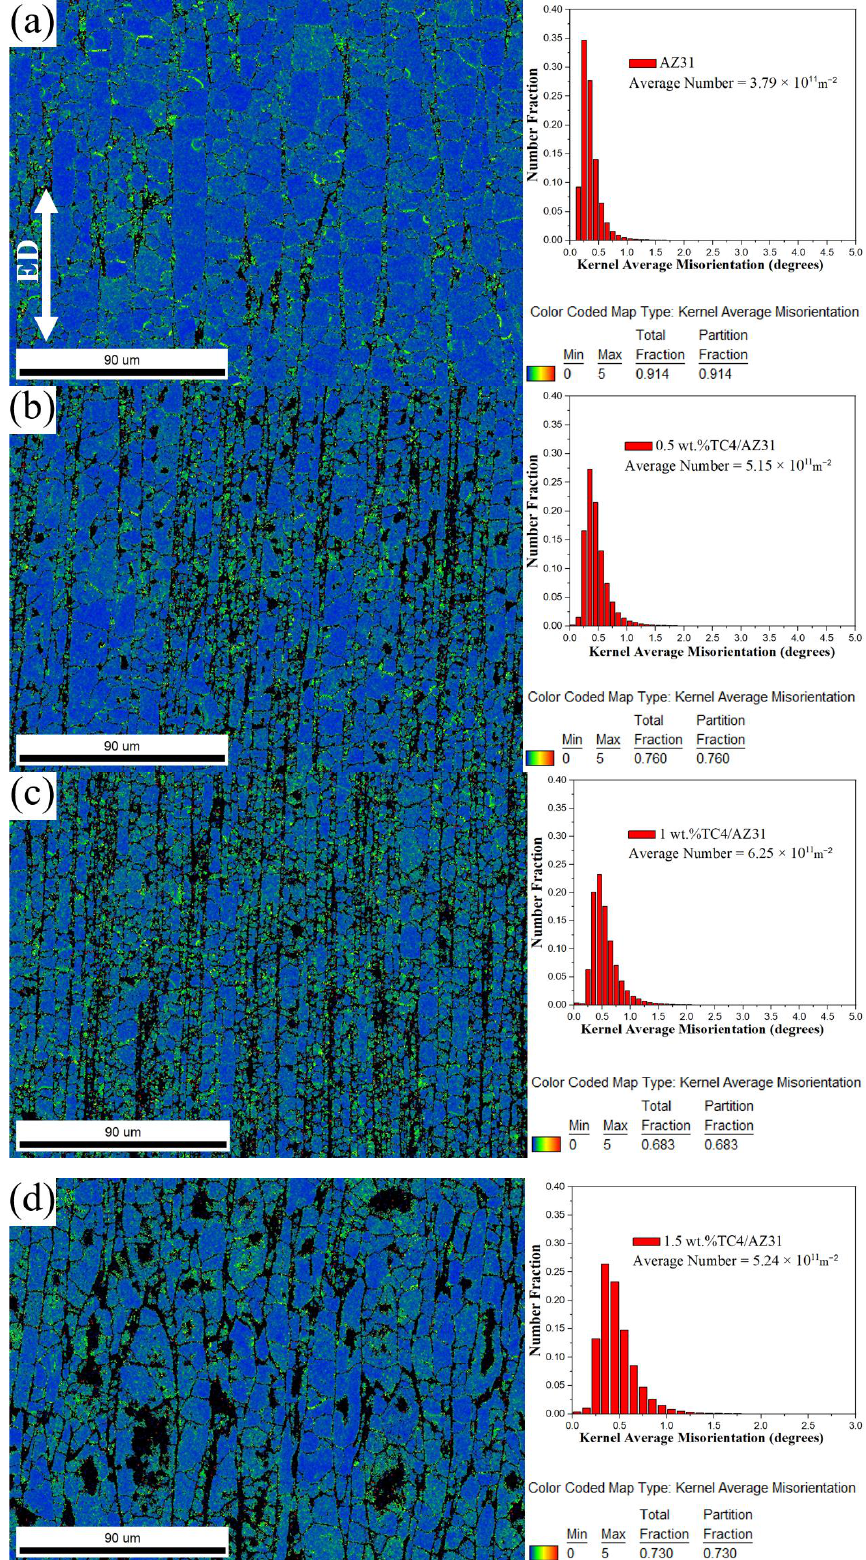
Figure 9. KAM map and KAM value distribution chart of ( a ) AZ31, ( b ) 0.5 wt.%TC4/AZ31, ( c ) 1 wt.%TC4/AZ31, and ( d ) 1.5 wt.%TC4/AZ31 as-extruded composites. ( c ) 1 wt.%TC4/AZ31, and ( d ) 1.5 wt.%TC4/AZ31 as-extruded